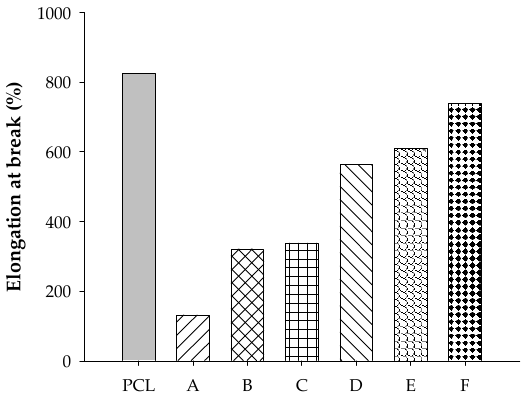
Figure 7. Elongation at break of PCL, A = STR5L / PCL at 40 / 60, B = STR5L / PCL at 50 / 50, C = STR5L / PCL at 60 / 40, D = ENR-50 / PCL at 40 / 60, E = ENR-50 / PCL at 50 / 50, and F = ENR-50 / PCL at 60 / 40.